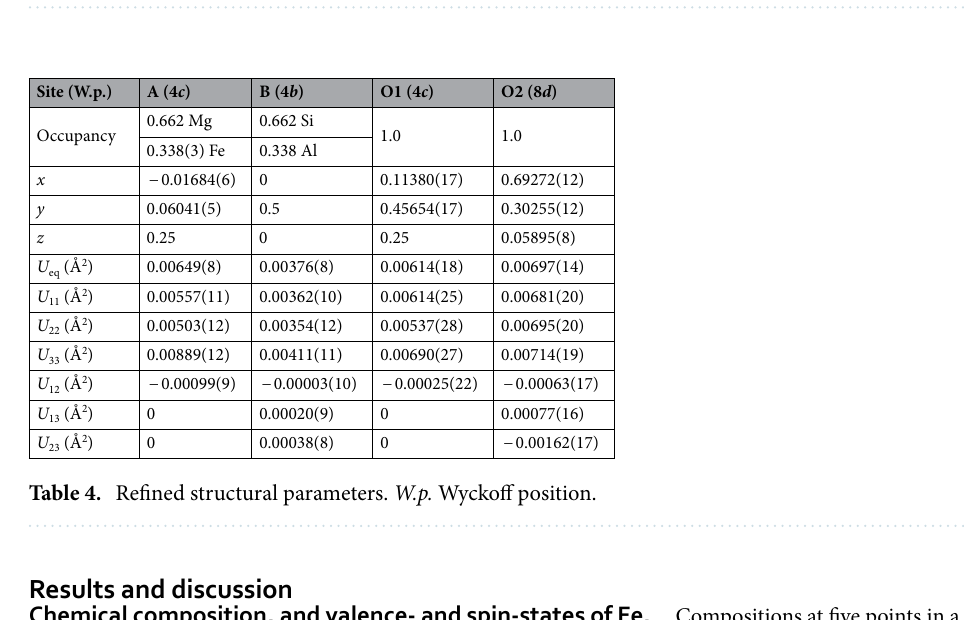
Table 3. Summary of crystallographic data, data-collection and refinement parameters.